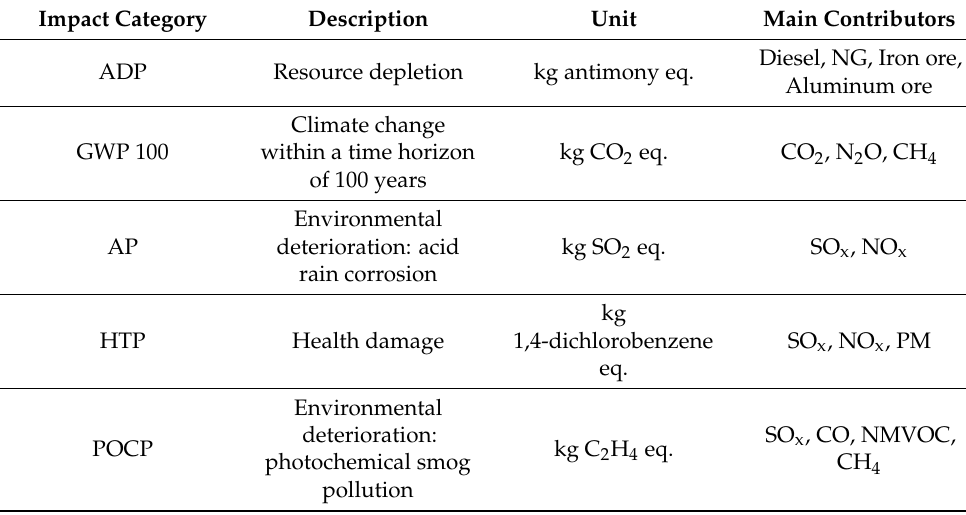
Table 4. The description, units, and main contributors of CML 2001 impact